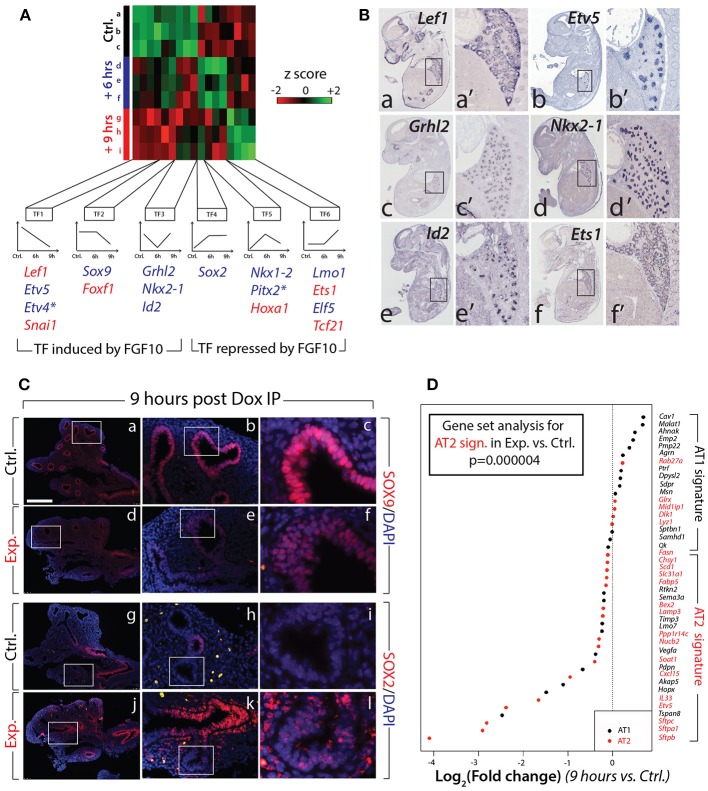
Identification of the transcription factors regulated by FGF10 and impacts on epithelial differentiation (A) Heatmap of highly regulated transcription factors between control, Dox-IP+6 h and Dox-IP+9 h conditions. Six classes of transcription factors (TF1-6) were identified based on their expression profiles. Genes in blue and in red are preferentially expressed in the epithelium and mesenchyme, respectively (asterisks denote genes found in both compartments). (B)
In situ hybridization on E14.5 lungs for Lef1 (a,a'), Etv5 (b,b'), Grhl2 (c,c'), Nkx2-1 (d,d'), Id2 (e,e'), and Ets1 (f,f'). (C) Validation by IF of changes in SOX9 (a–f) and SOX2 (g–l) expression in experimental vs. control lungs. Scale bar: (a,d,g,j) 300 μm; (b,e,h,k) 100 μm; (c,f,i,l) 33 μm. (D) Expression of AT1 and AT2 markers in 9 h vs. control lungs. Note the significant global reduction in the expression of the AT2 markers. (n = 3; see Materials and Methods for details on the statistical analysis of gene sets).